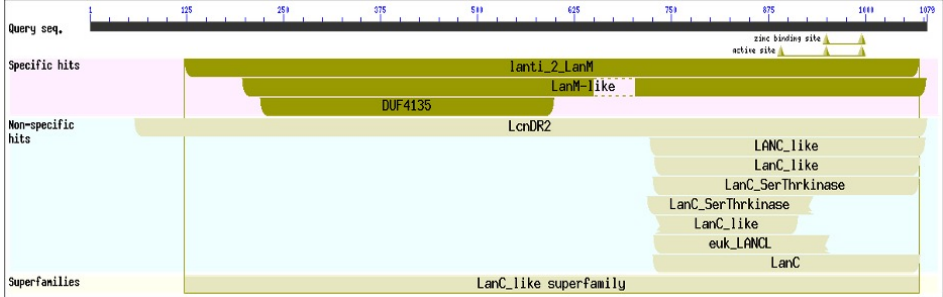
Figure 2. Domain characterization of lantibiotics biosynthesis enzyme using the NCBI Conserved Domain